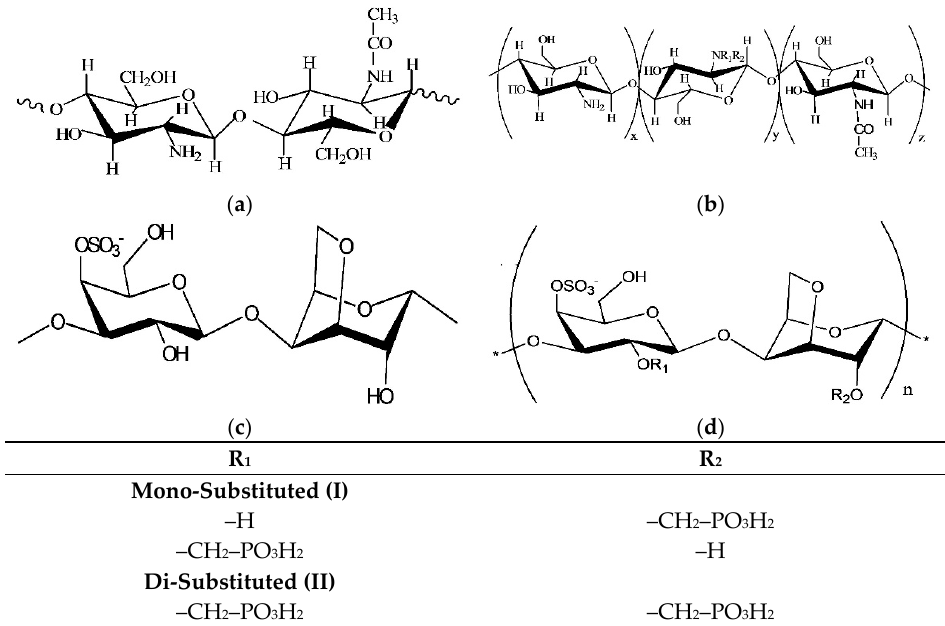
Figure 1. Molecular structure of ( a ) chitosan; ( b ) N -methylene phosphonic chitosan (NMPC); ( c ) κ -carrageenan; and ( d ) O -methylene phosphonic κ -carrageenan (OMPk).